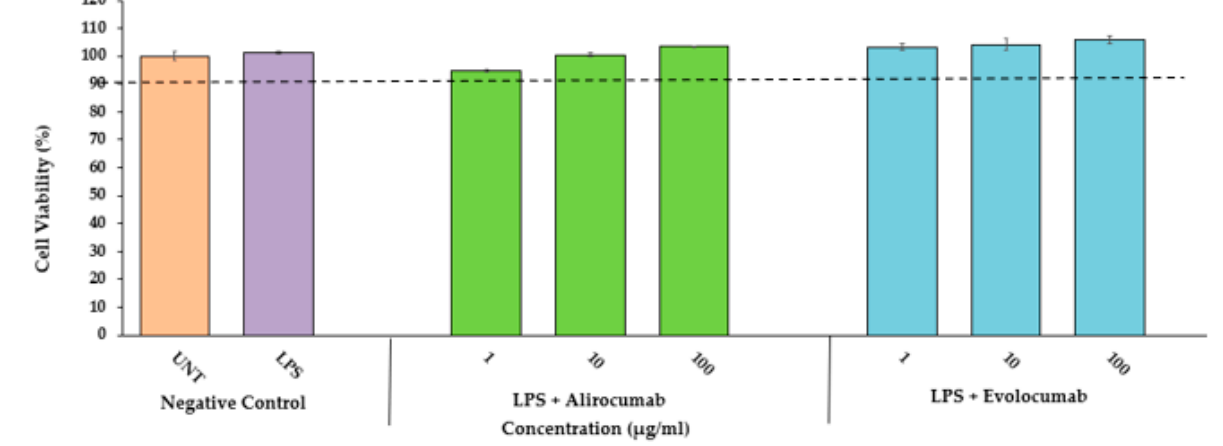
Figure 1. Cytotoxic effects of alirocumab and evolocumab on stimulated HCAEC. Results are presented as percentages (%) of control (untreated cells). Data are expressed as mean ± SD (n = 9). Abbreviation: UNT (Untreated), LPS (Lipopolysaccharides).